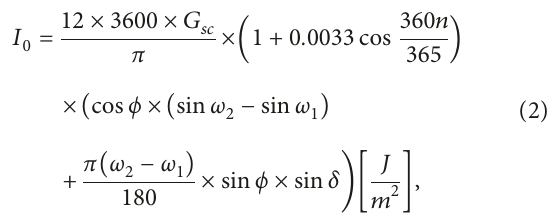
Figure 1: Configuration of the system for simultaneous generation of electricity and solar